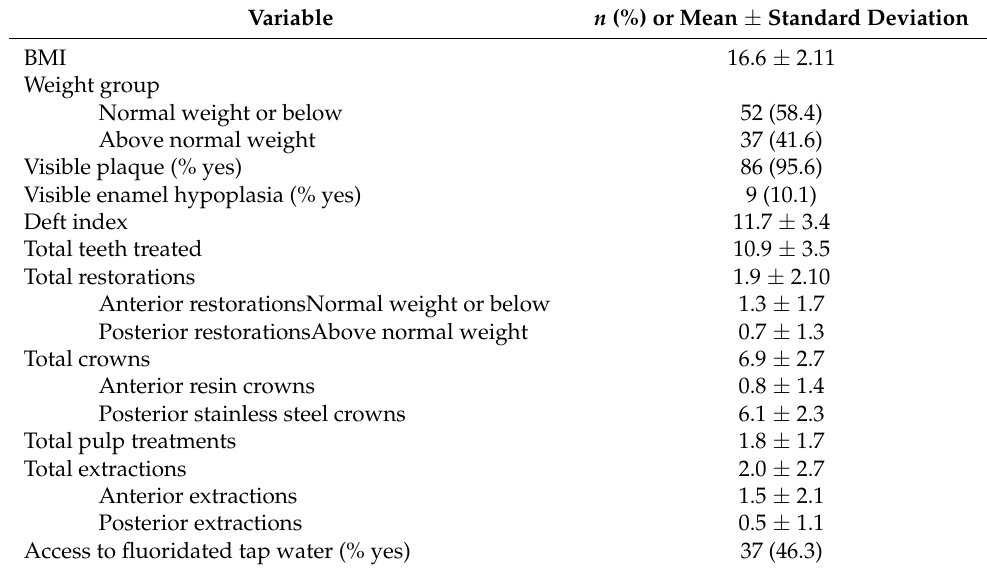
Table 3. Summary of clinical findings and dental treatment.